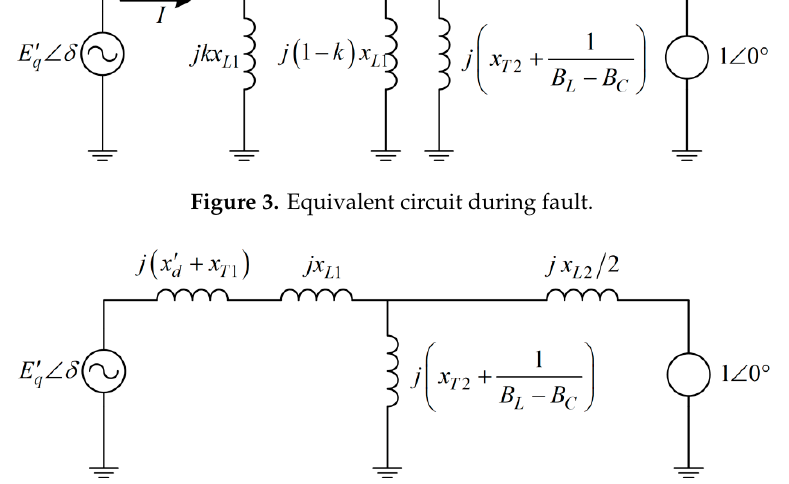
Figure 2. Pre-fault equivalent circuit.